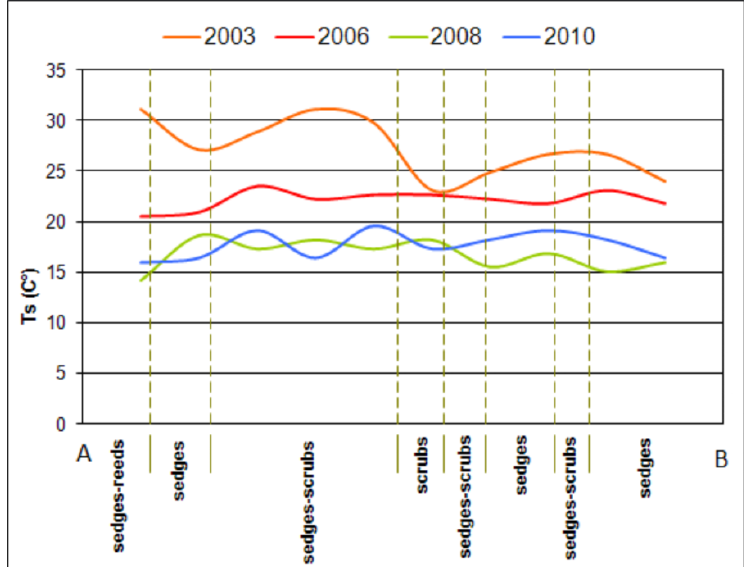
Figure 15. T along the transect A–B calculated from AVHRR s